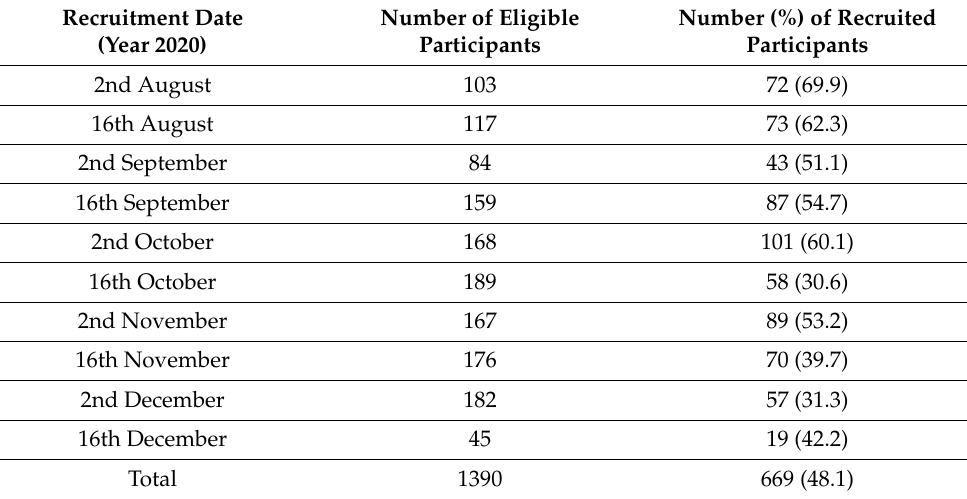
Table 1. Participant